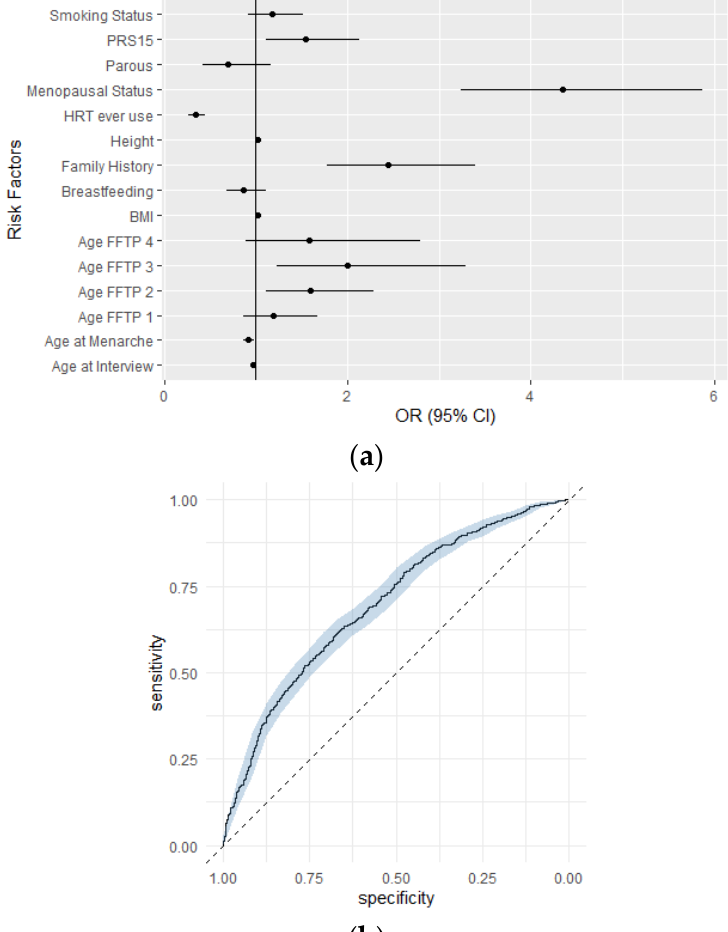
Figure 2. Association of the integrated risk model with breast cancer risk in the MASTOS study: ( a ) Associations between risk factors included in the final integrated risk model with breast cancer risk in the MASTOS study. Estimated ORs (95% CI) of each risk factor for breast cancer risk are illustrated; Age FFTP category 5 (Nulliparous) was included in the category 0 of Age FFTP (reference). ( b ) ROC curve for the integrated risk model, (AUC 0.70, 95% CI 0.67–0.72). To assess the ability of the integrated risk model to discriminate individuals based on their disease status, MASTOS dataset was divided into deciles based on the predicted risk probability of the integrated risk model. As illustrated in Table 2, compared with the 5th decile, the estimated OR (95% CI) in the first decile was 0.36 (0.22–0.57), with p -value = 1.55 × 10 − 5 , and included 15.4% of controls, and 4.4% of cases. Similarly, the estimated OR (95% CI) in the 2nd quartile was 0.48 (0.31–0.75), with p -value = 0.001 and included 15% of controls and 5.8% of cases. In contrast, the estimated OR (95% CI) in the 9th decile was 3.22 (2.04–5.13) with p -value = 6.46 × 10 − 7 and included 5% of controls and 13% of cases, and in the last decile the estimated OR (95% CI) was 4.58 (2.88–7.4), with p -value = 2.44 × 10 − 10 and included 4.2% of controls and 15.6% of cases (Table 2, Figure